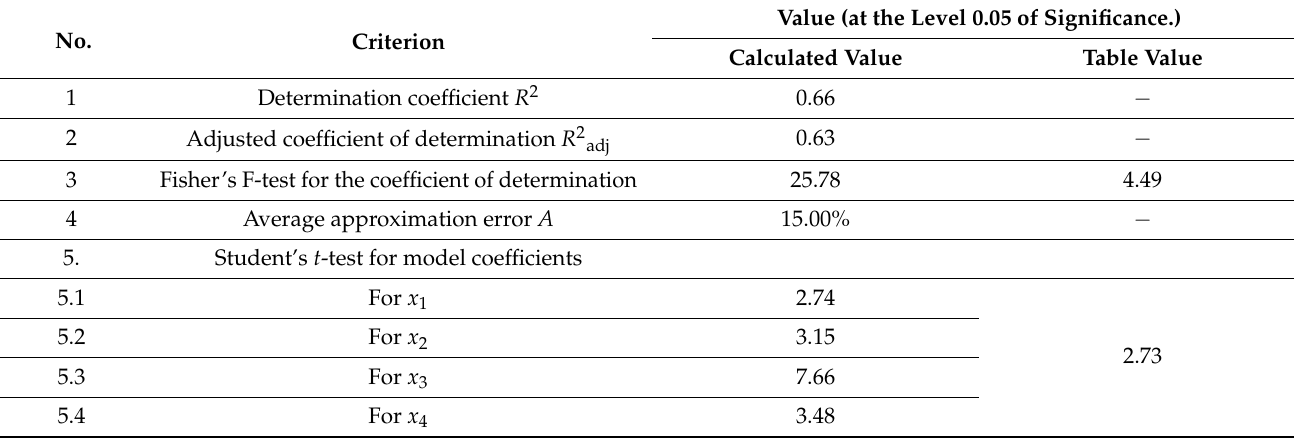
Table 8. Quality characteristics of the cadastral value assessment model.